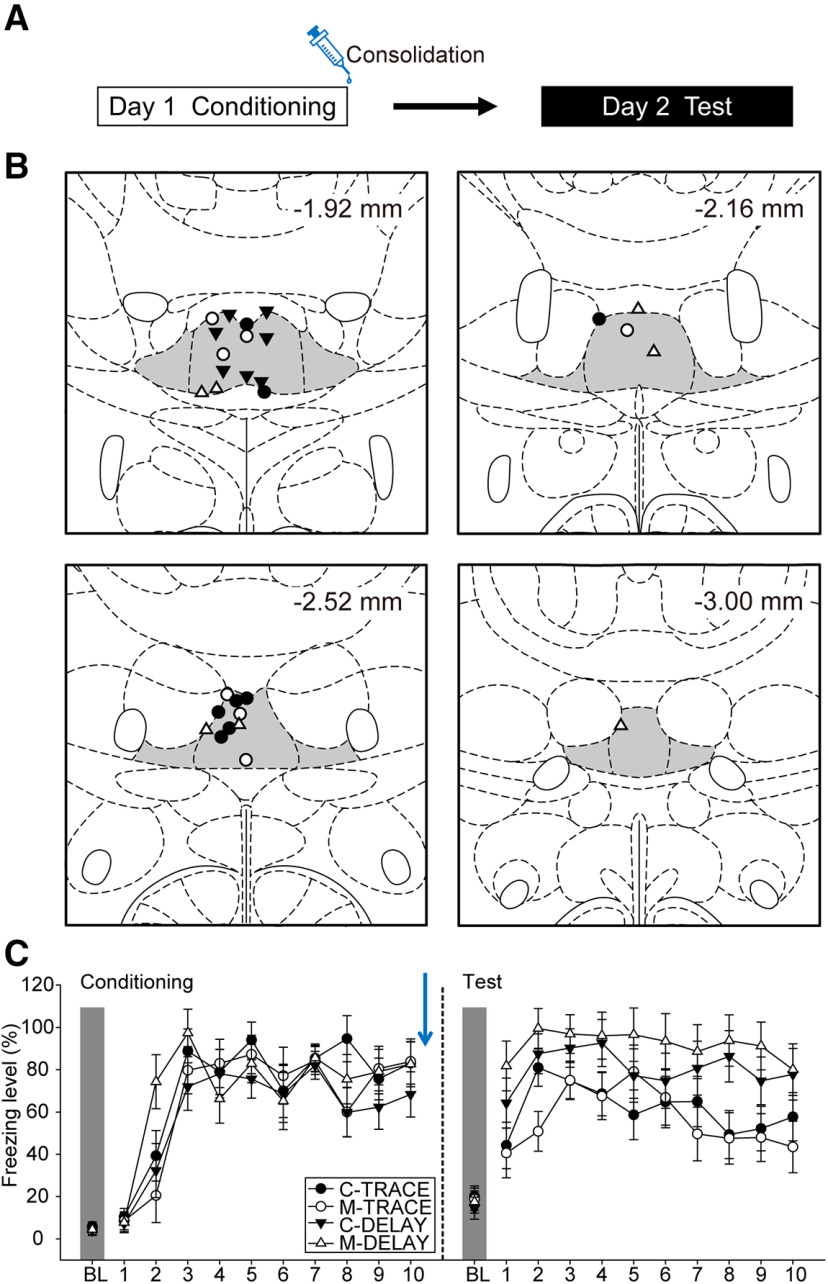
The ReRh was not involved during the consolidation of trace fear conditioning. A, Experimental design. Animals underwent a 2-d behavioral experiment, in which the animals received drug infusion immediately after conditioning (day 1). B, Injector tip placements of all the animals included in data analyses at levels −1.92, −2.16, −2.52, and −3.00 mm posterior relative to bregma. The gray areas marked in the atlas are the Re and ventral Re. C, The freezing behavior of C-TRACE (n = 8), M-TRACE (n = 7), C-DELAY (n = 7), and M-DELAY groups (n = 7) when injections were performed after conditioning.